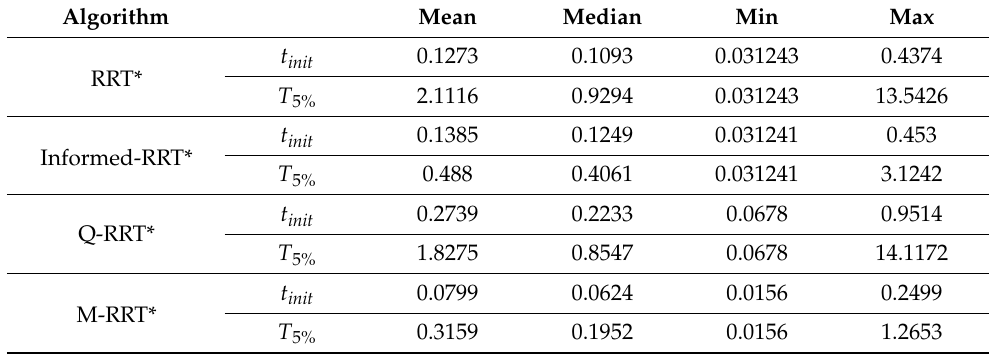
Table 2. t init and T 5% of four algorithms in the regular environment.